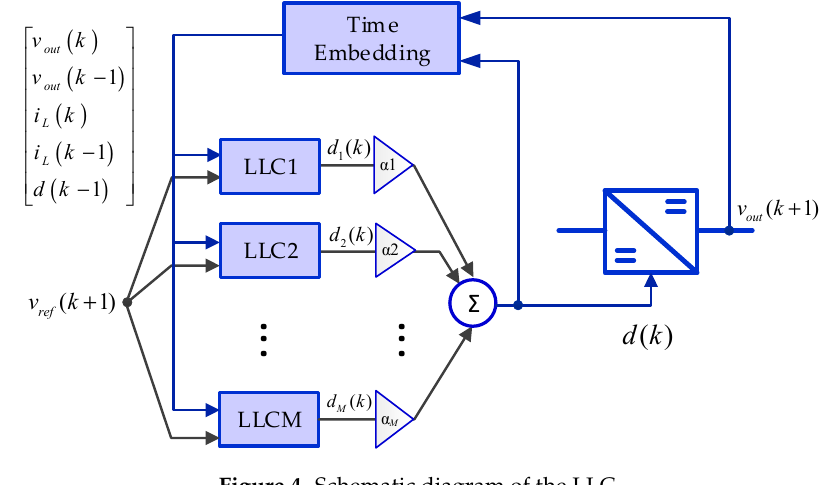
Figure 4. Schematic diagram of the LLC.